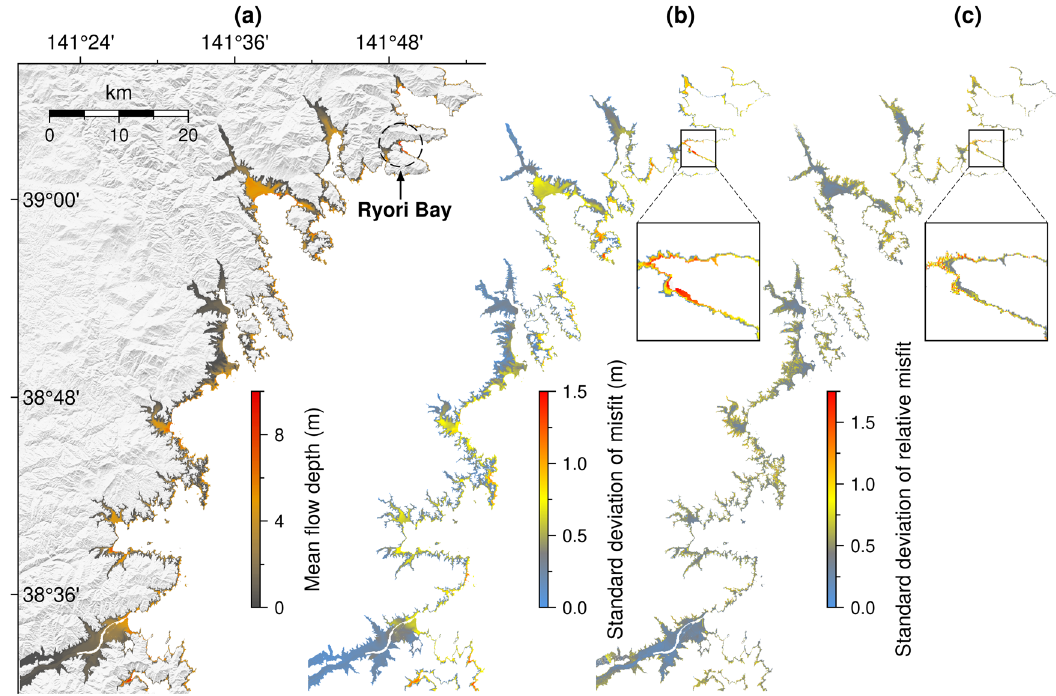
Fig.5|Thespatialvariabilityofmis fi tonthetestset.a Themean fl owdepth. b Thestandarddeviationofmis fi t. c Thestandarddeviationofrelativemis fi t.Calculations of a – c are based on all 480 samples on the test